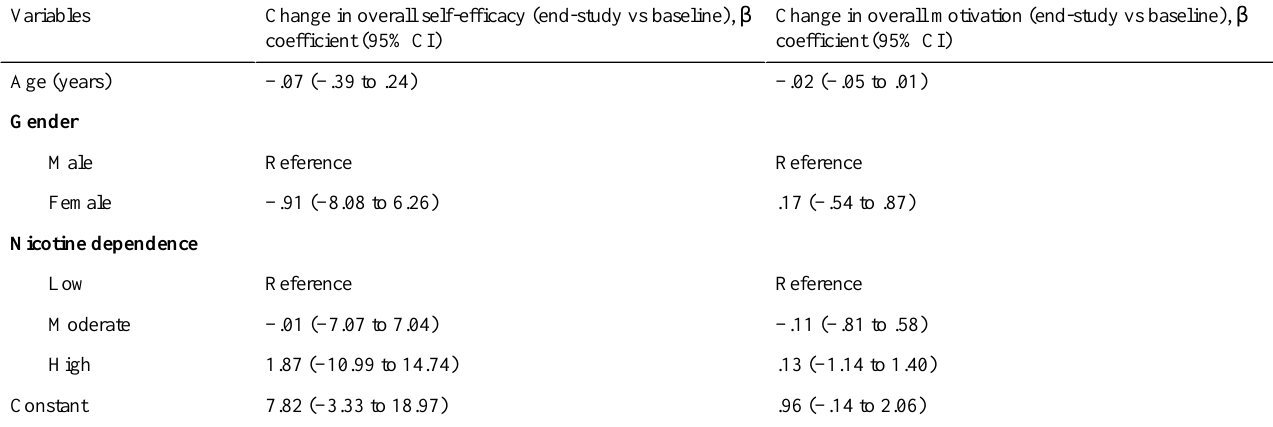
Table 3. Linear regression models examining factors associated with change in self-efficacy and change in motivation to quit between end-study and baseline